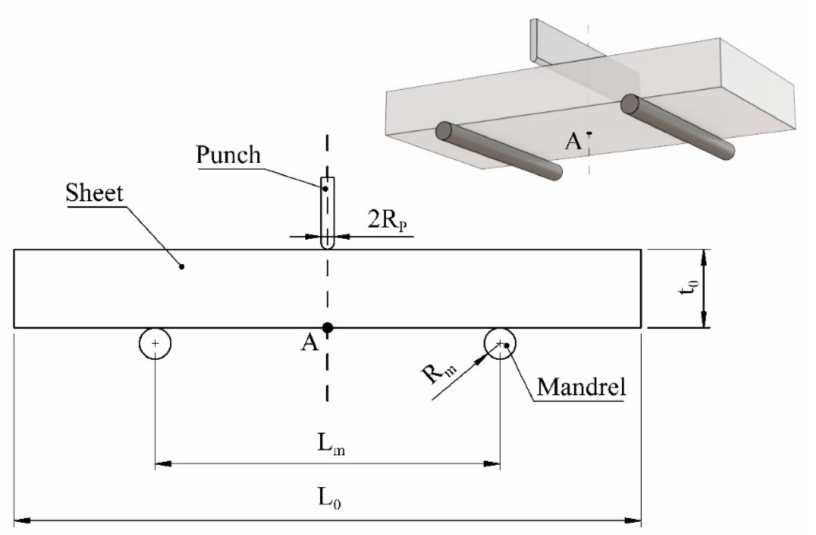
Figure 2. Schematic of three-point bending